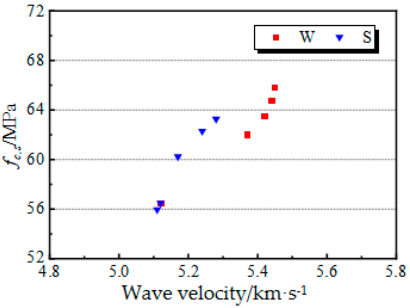
Figure 9. Relationship between longitudinal wave velocity and static compressive strength. The fitting results are shown in (6), and the relevant relation diagram is shown in Figure 10. The fitted correlation coefficient R 2 = 0.9679 (the W group), R 2 = 0.9471 (the S group). Thus, the correlation was high, and the fitting results were optimal. ( b ) Figure 10. Fitting curve of the static compressive strength and wave velocity for the test pieces ( a ) the W group; ( b ) the S group. The compressive strength and erosion resistance coefficient were used to analyze the degradation law of concrete test pieces. Therefore, according to classical mechanics, D , the damage variable, is defined by the elastic modulus of material as such: 1 E D E = − (7) where E —the elastic modulus of material in its initial state; E —the elasticity modulus of material after damage The following can be obtained according to the Formula (8): ( (8) Substituting it into the Formula (8), the test piece damage variable defined by the wave velocity can be obtained as: